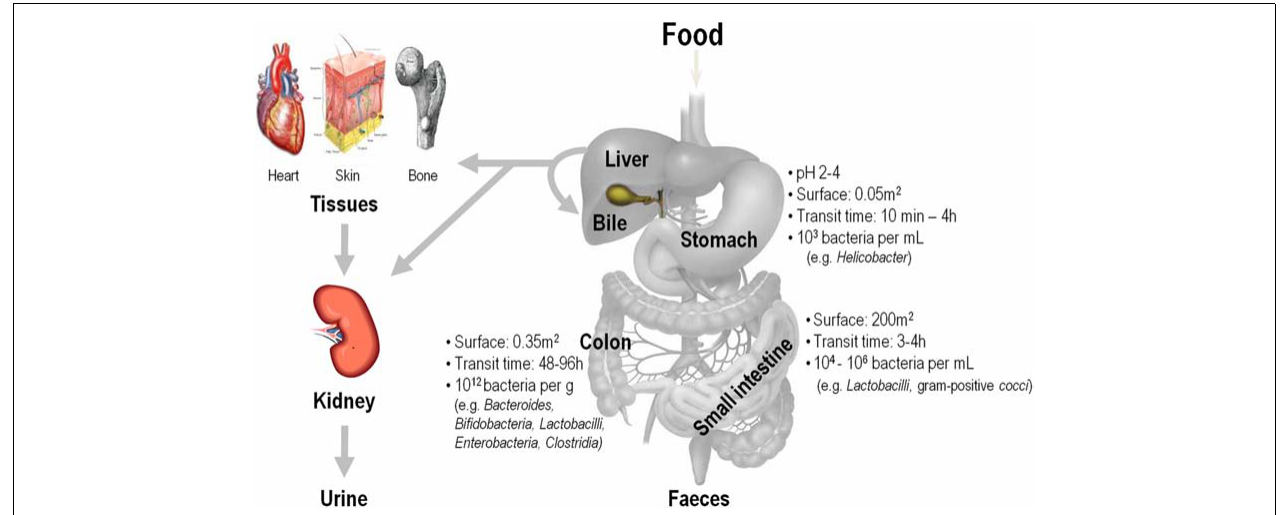
FIGURE 4 | Foodcompounds (macro- and micronutrients) are digested and absorbed the gastro-intestinal tract (GIT) before they may reach various other body tissues. In the GIT, food stuffs interact with and are partly metabolized by an enormous quantity and diversity of bacteria residing in the stomach and, in particular, in the